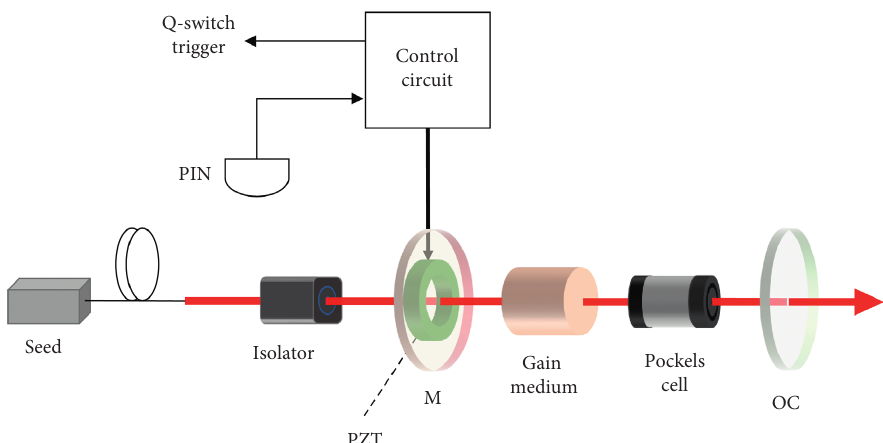
Figure 13: Schematic of seed amplification technology.